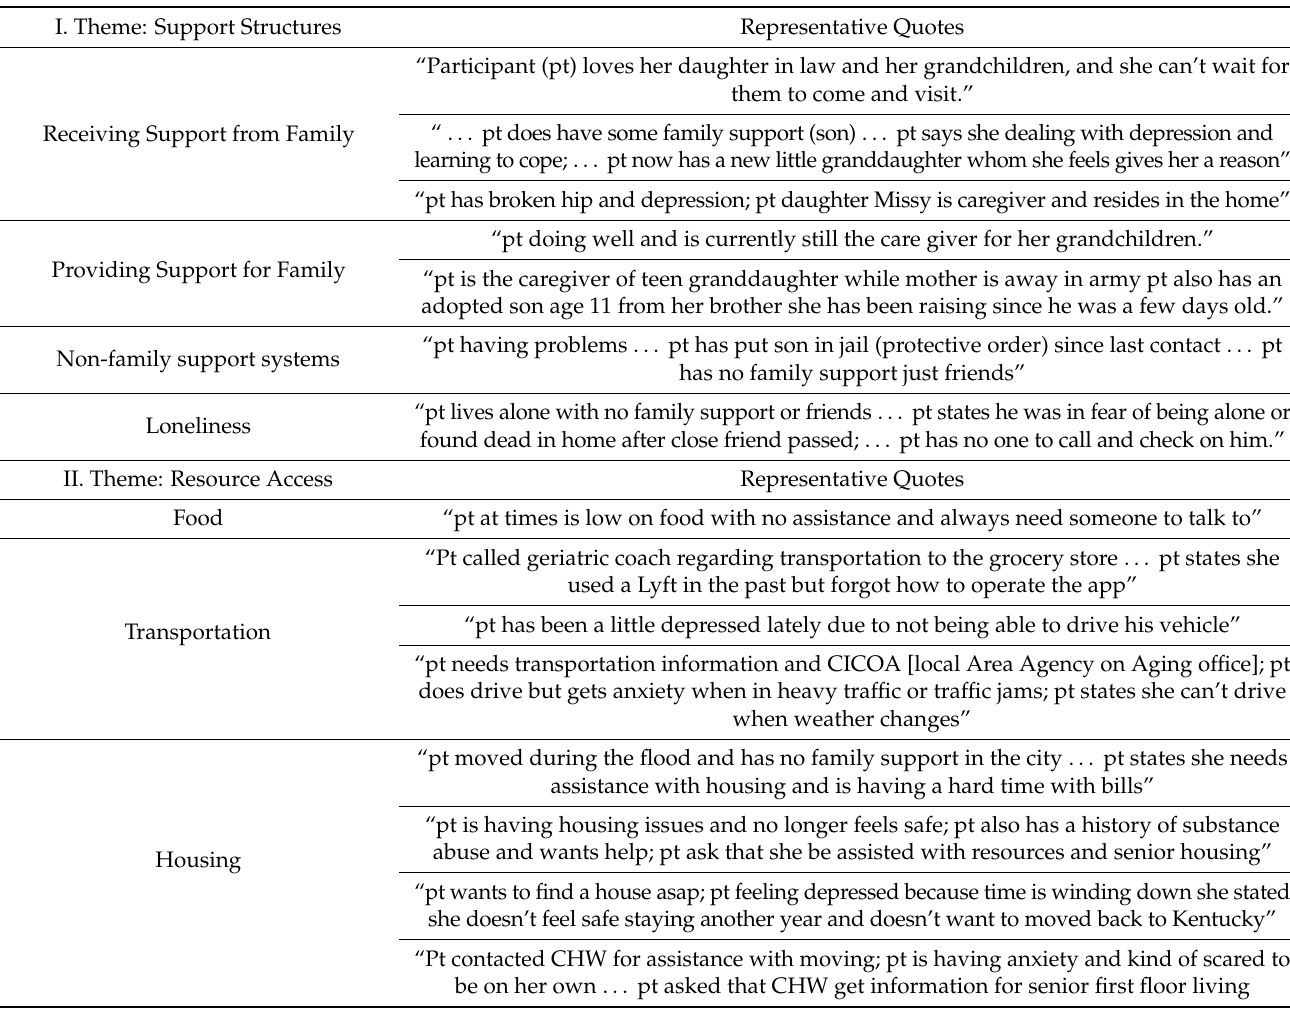
Table 3. Emergent Themes from Qualitative Analysis with Representative